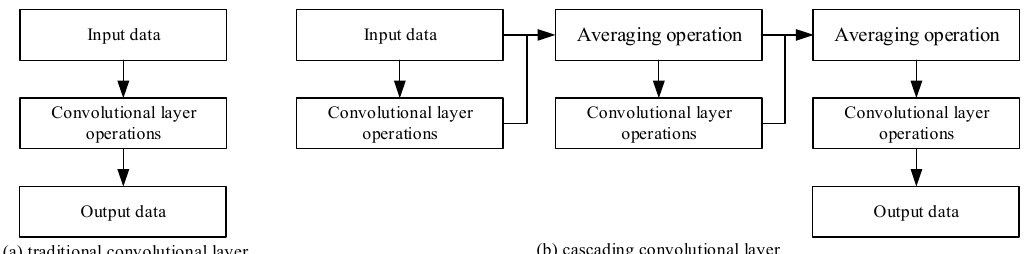
Figure 2. Comparison with traditional convolutional layer and cascading convolutional layer.